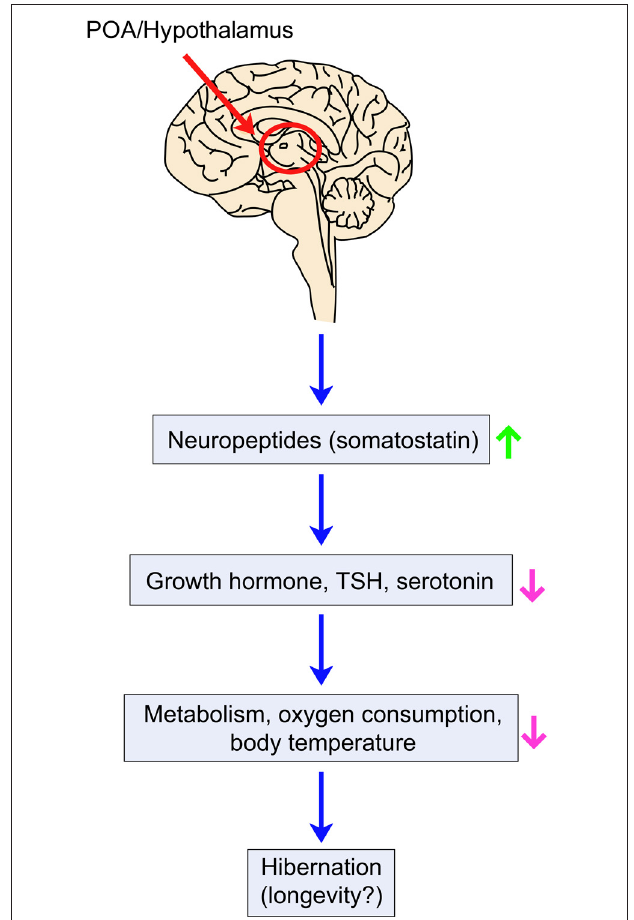
FIGURE 5 | Hypothetical model of longevity and hibernation modulation by thermoregulation in mammals. Ambient temperature decrease is sensed by cold-activated receptors and transmitted to the POA of the hypothalamus. Neuropeptidessuch as somatostatin may be secreted to inhibit growth, cellular proliferation, body core temperature, oxygen consumption, and metabolic activities by decreasing the levels of growth hormone, thyroid-stimulating hormone (TSH) and/or serotonin. These changes appear to contribute to the hibernation process and may influence